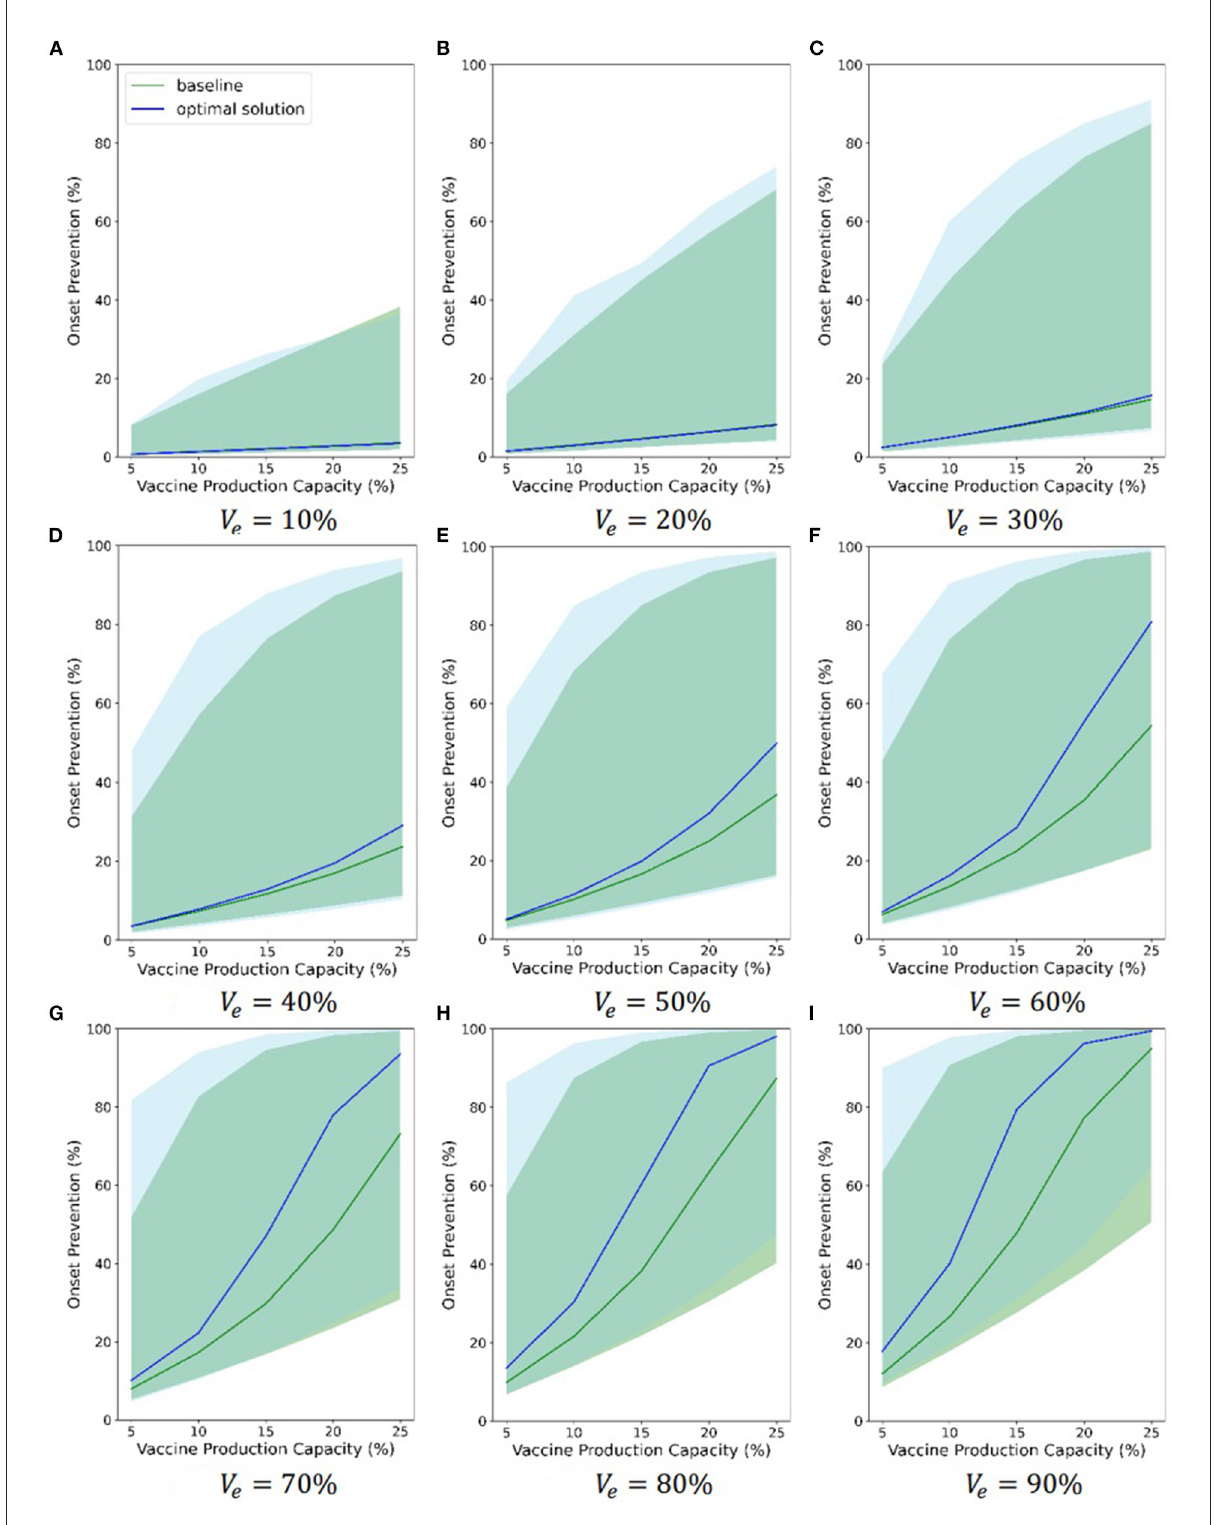
FIGURE7 Onsets prevention comparation between chosen optimal strategy and